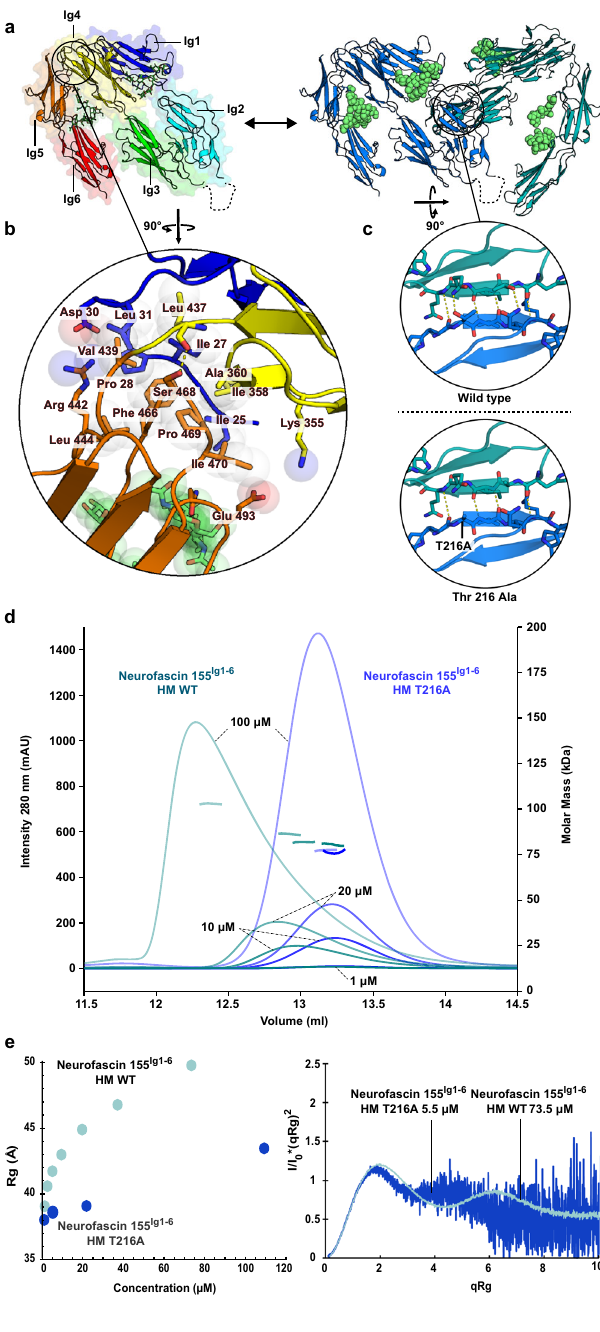
(Supplementary Fig. 3a). Interestingly, L1 and neurofascin 186 inser- tions within the N-terminus of fi ve and six residues, respectively, may potentially impact the overall architecture